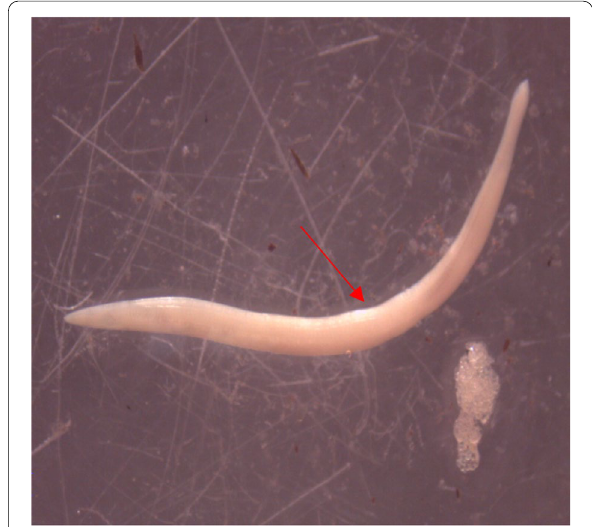
Fig. 11 Adult Enterobius sp.